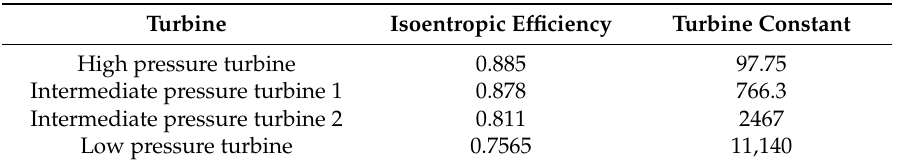
Table 1. Turbine